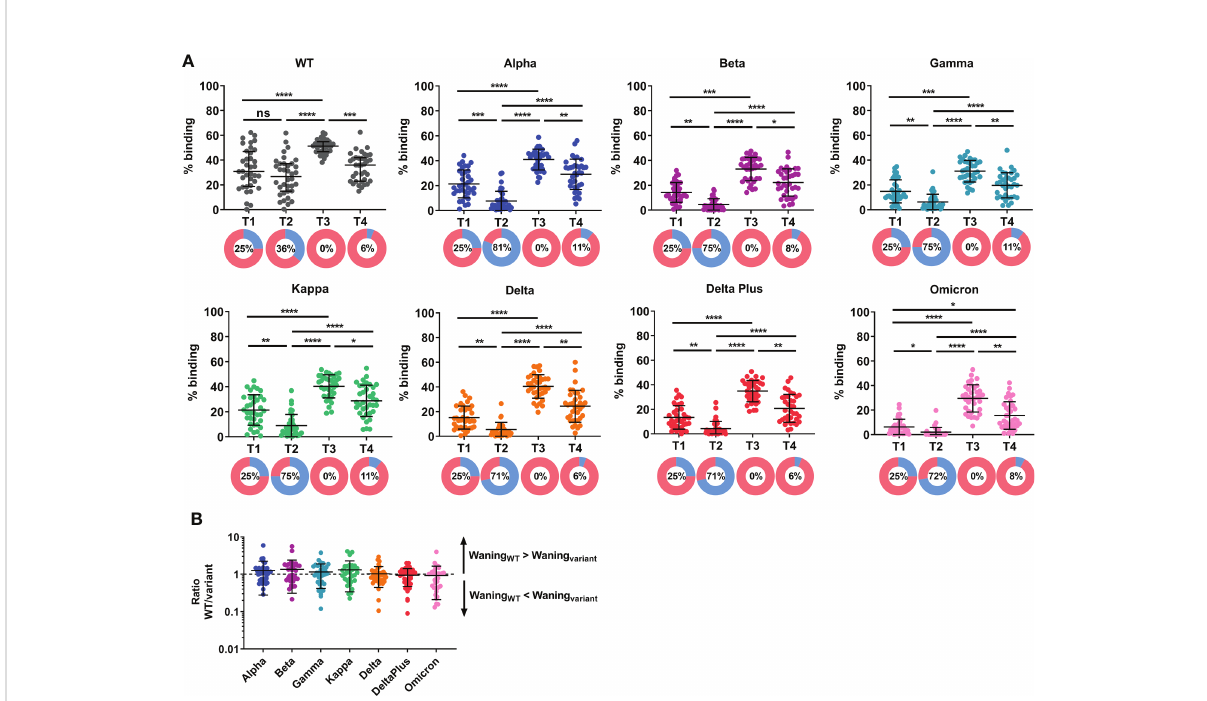
FIGURE 1 Induction and waning of antibody response against WT and variant Spike following booster vaccination. Plasma samples were screened for binding against full-length (A) wildtype (WT) and variant Spike (Alpha, Beta, Gamma, Kappa, Delta, Delta Plus and Omicron) in elderly individuals at two months (T1) and fi ve months (T2) following primary vaccination, and one month (T3) and four months (T4) following a third dose (administered 189-270 days post fi rst-dose). N=36. Pie chart shows the proportion of individuals with antibody responses above 25 th percentile of cohort response at two months following primary vaccination, T1 (in pink) and individuals with antibody responses below 25 th percentile of cohort response at T1 (in blue; de fi ned as low responders); Number in pie chart indicates the proportion of low responders (blue in pie chart). (B) The reduction in antibody response against variant Spike at T4 (compared with T3) was compared with the reduction in WT Spike-speci fi c and expressed as a ratio (WT/variant). A ratio >1 indicates that the waning of antibody response against WT Spike is more than waning of antibody response against variant Spike. N=36. To compare between multiple groups, Kruskal-Wallis tests and post hoc tests using Dunn ’ s multiple comparison tests were used. *, P-value <0.05; **. P-value <0.01; ***, P-value <0.001; ****, P-value <0.0001; ns, not signi fi